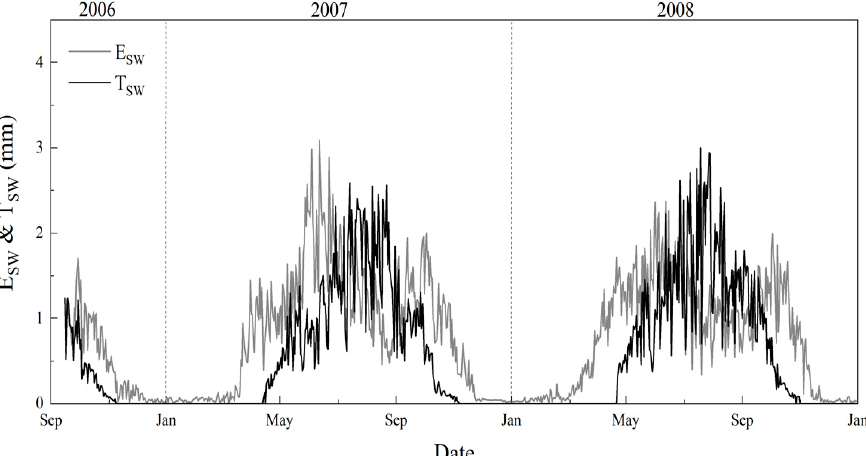
Figure 4. Annual variations in soil evaporation ( E SW ) and plant transpiration ( T SW ) estimated by the S–W model in the degraded meadow for 2006–2008.